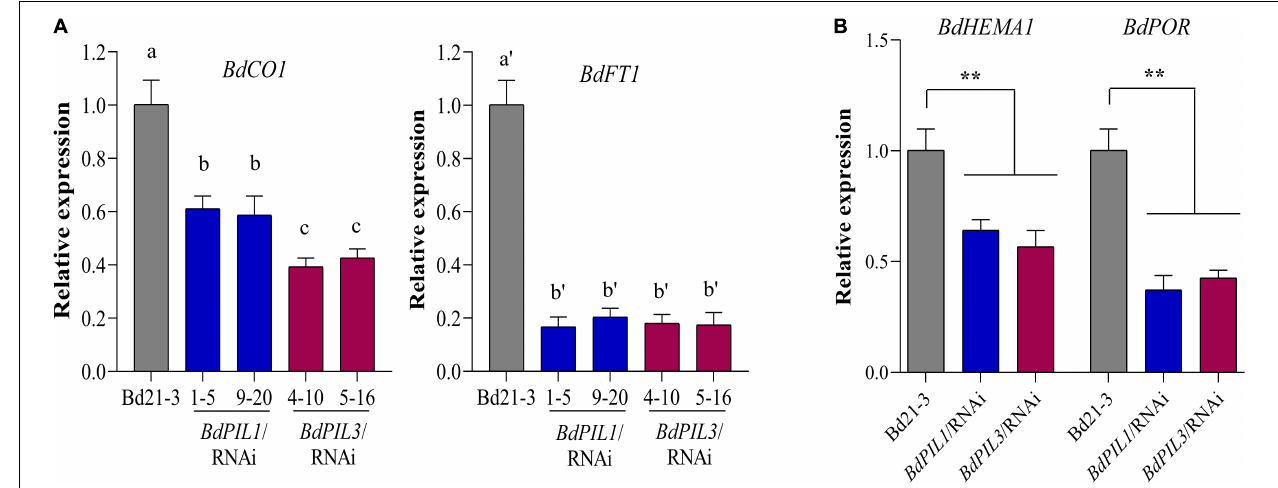
FIGURE 6 | Gene expression analysis related to flowering and chlorophyll biosynthesis in the BdPIL1/ RNAi and BdPIL3/ RNAi plants. (A) qRT-PCR analysis of flowering genes, BdCO1 (Bradi1g43671) and BdFT1 (Bradi1g48830). RNA was extracted from 8-week-old plants, and the relative expression levels were estimated by setting the transcript level in Bd21-3 as 1, using BdUBC18 expression levels for data normalization. Data represent the means ± SD of three independent replicates, and different letters represent significantly different means ( P < 0.01, Duncan’s multiple range test). (B) qRT-PCR analysis of genes related to chlorophyll biosynthesis, BdHEMA1 ( Bradi3g30160 ) and BdPOR ( Bradi5g26230 ). RNA was extracted from 5-day-old dark-grown seedlings. Significant changes in comparison to Bd21-3 are indicated by ** ( P < 0.01, Tukey’s